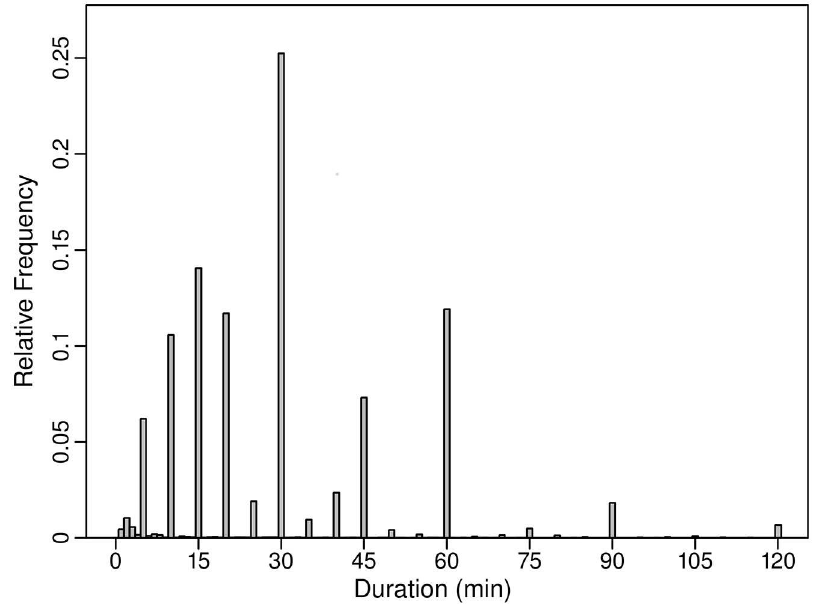
Fig 1. Weighted histogram of durations of grooming events reported in ATUS from 2003 to 2012. Only events with a duration (cid:20) 120 min are included.N =